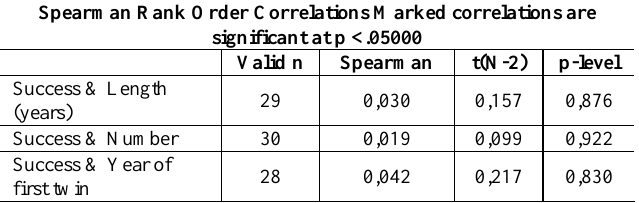
Table 2: Alliance experience and alliance success